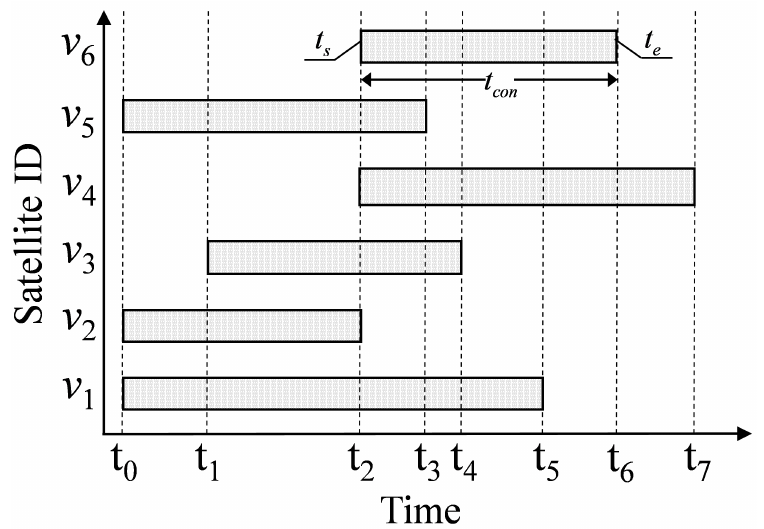
Figure 4. Satellites coverage time at different